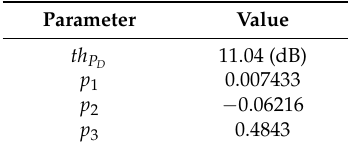
Table 1. Parameters used in the proposed NLOS Identification and Error Mitigation